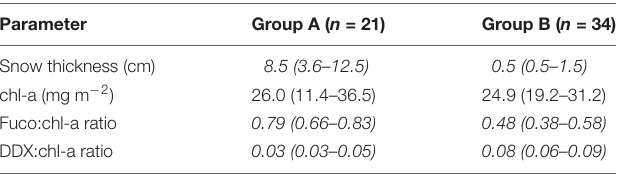
TABLE 1 | Mean values (range in brackets) of snow thicknesses and pigment properties for the two groups of core samples identified by cluster analysis. Parameter